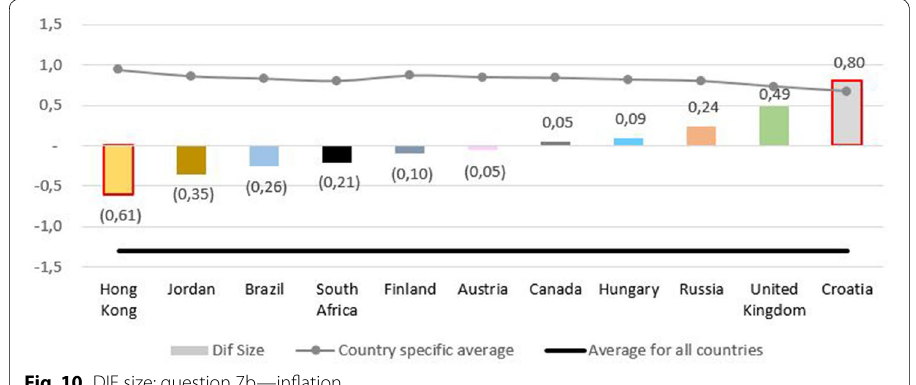
Fig. 10 DIF size: question 7b—inflation